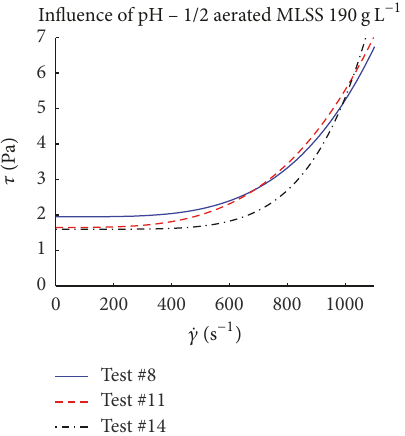
Figure 12: Shear stress versus rate of deformation: influence of pH for 1/2 aerated